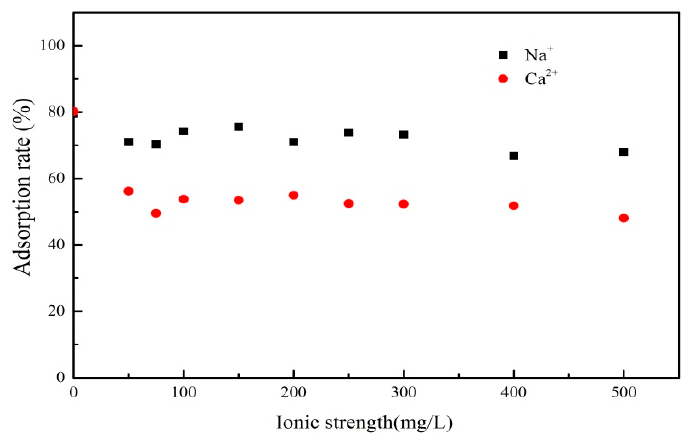
Figure 8. The effect of ionic strength on the adsorption of PRO onto ATP/Fe 3 O 4 /GO.